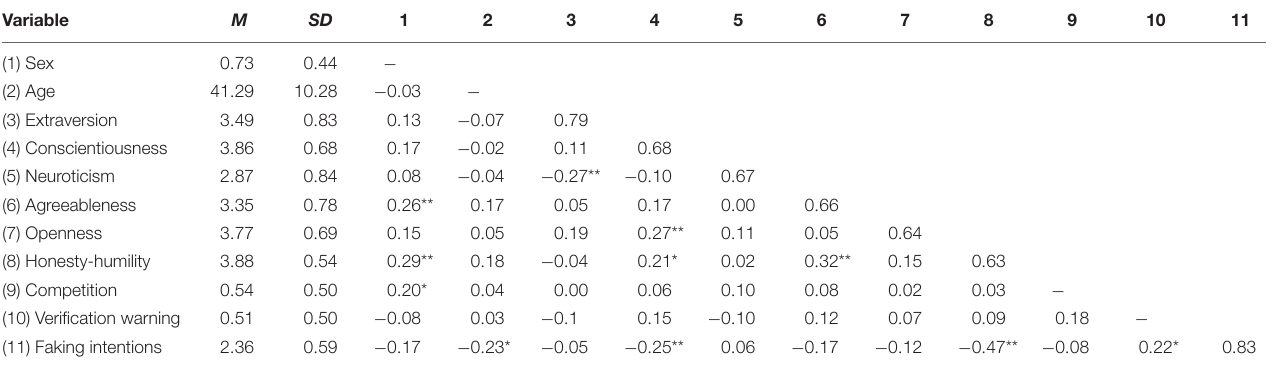
TABLE 4 | Correlations, means, and standard deviations among all study variables in Study 2.